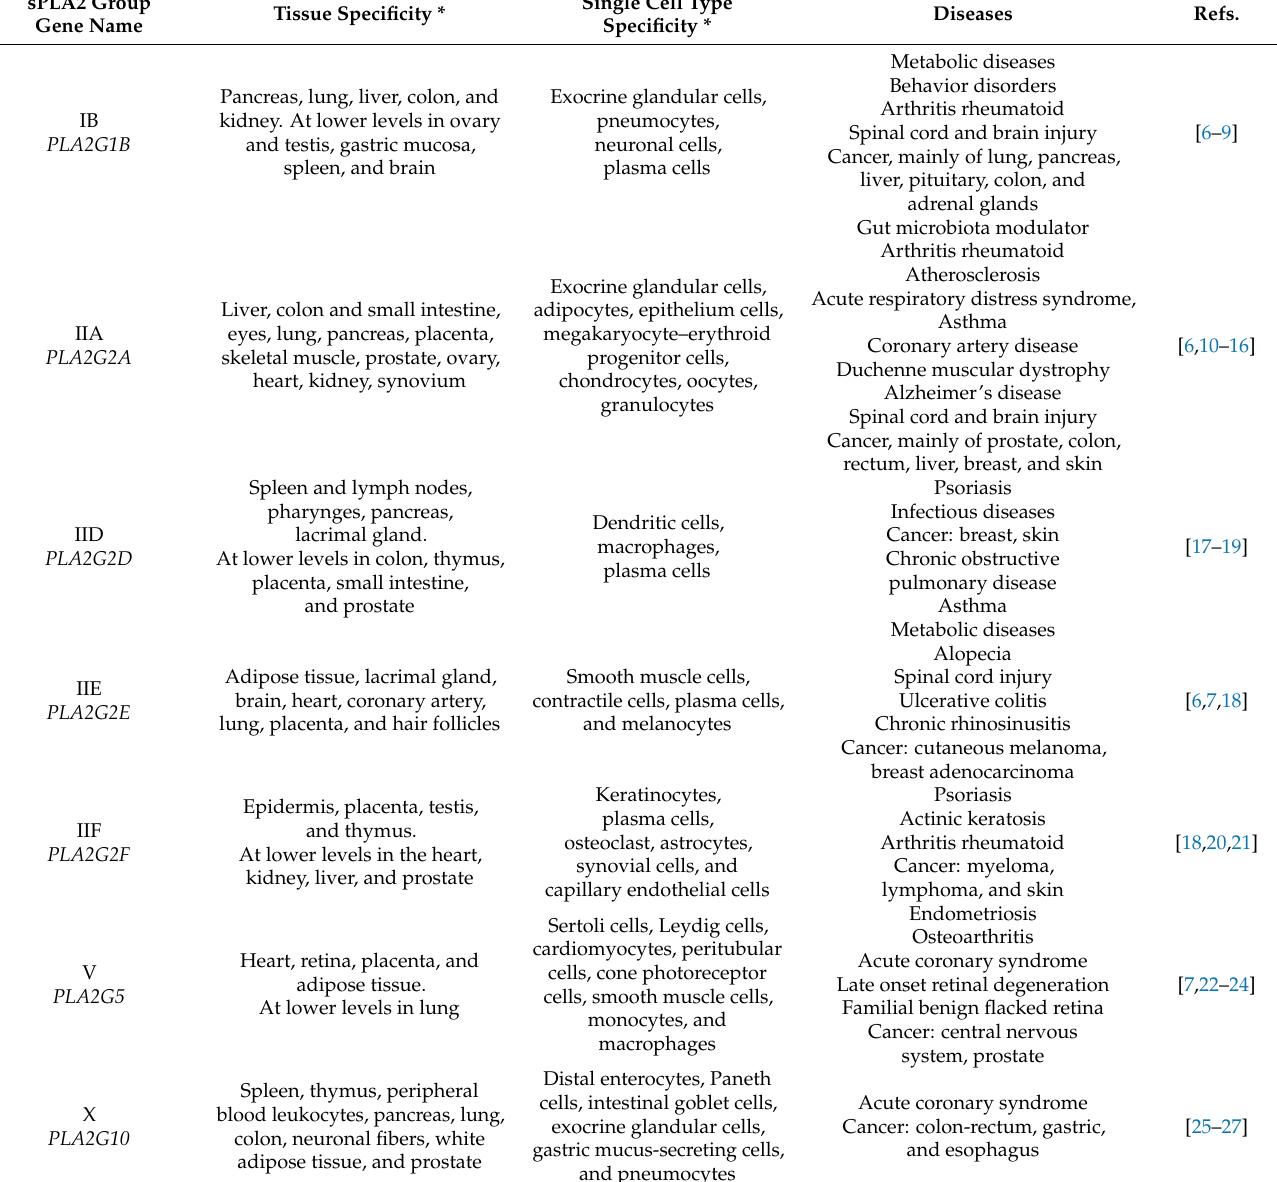
Table 1. Expression data and main diseases where conventional sPLA2s are